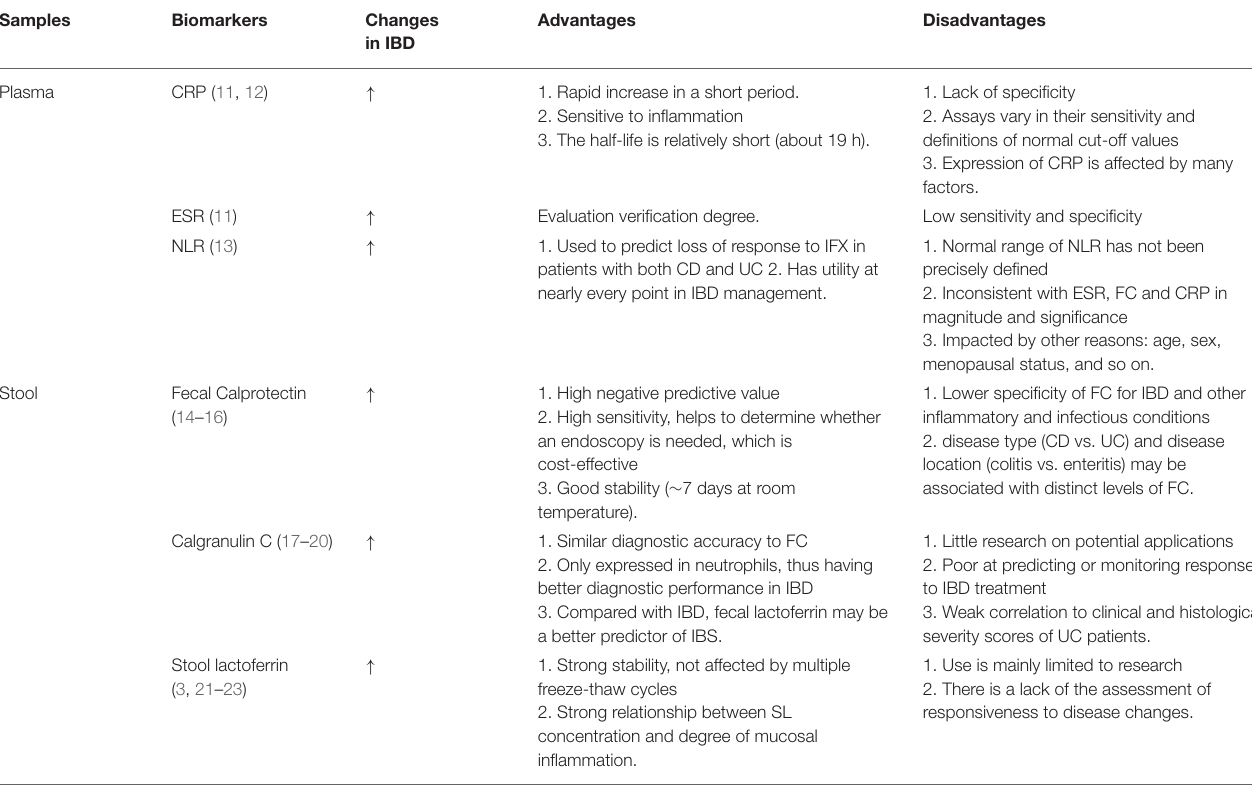
TABLE 1 | Commonly used biomarkers in blood and stool.